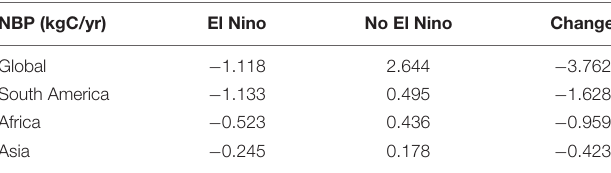
TABLE 2 | Total and change in NBP Globally and by region, with and without El Niño simulated by JULES-INFERNO.